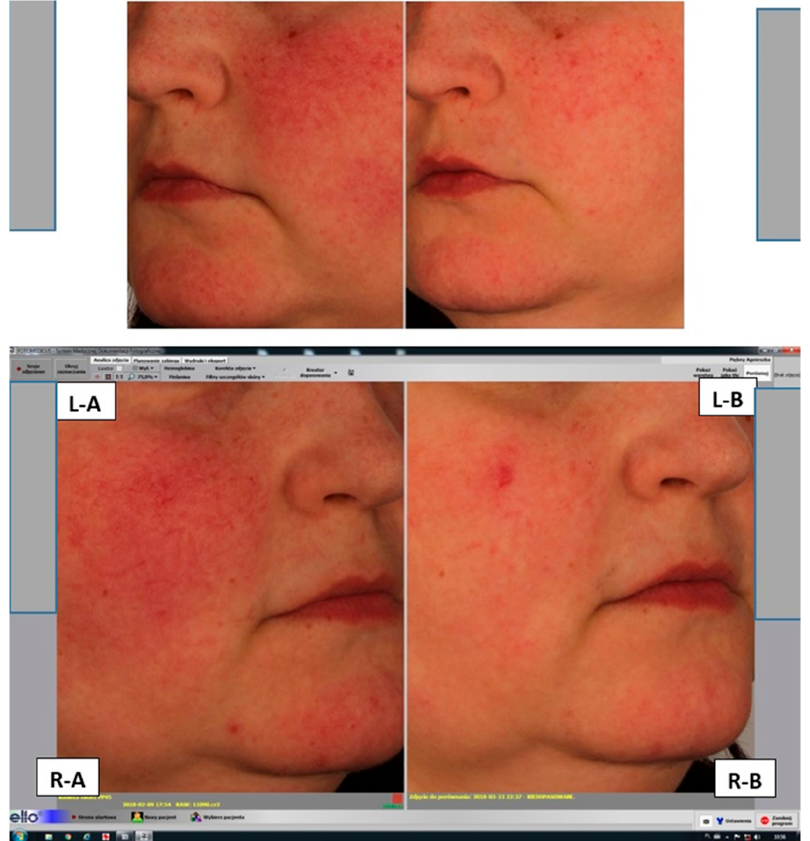
Figure 3 . The left cheek (L) and the right cheek (R) before the first treatment (A) and after the third treatment (B), in cross-polarized light.